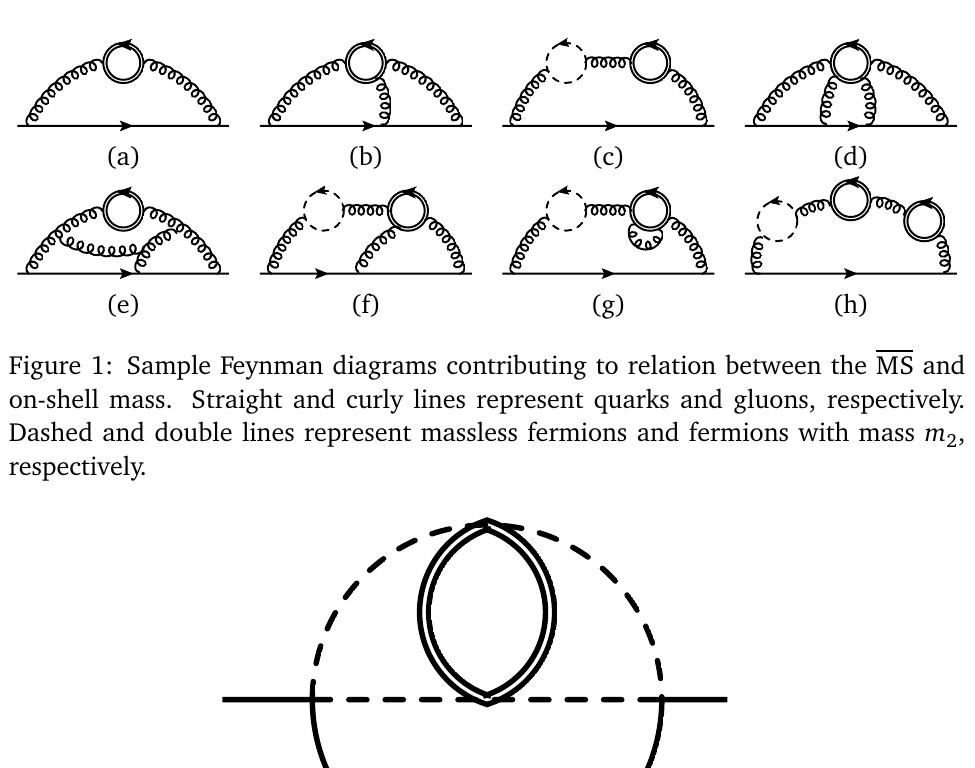
Figure 2: Graphical representation of the master integral in Eq. (2). Dashed, solid and double lines represent scalar propagators of mass 0, m